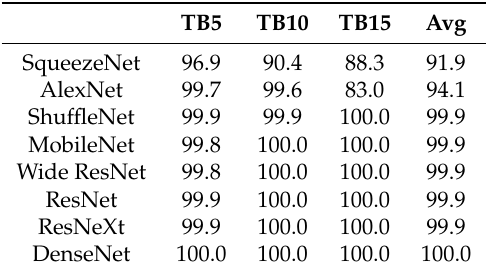
Table 5. Architecture baseline performance with free-space sets.